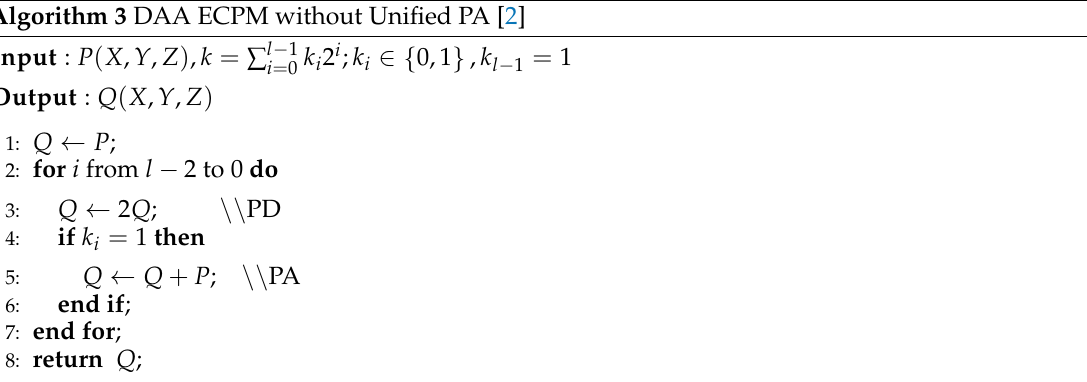
Algorithm 3 DAA ECPM without Unified PA